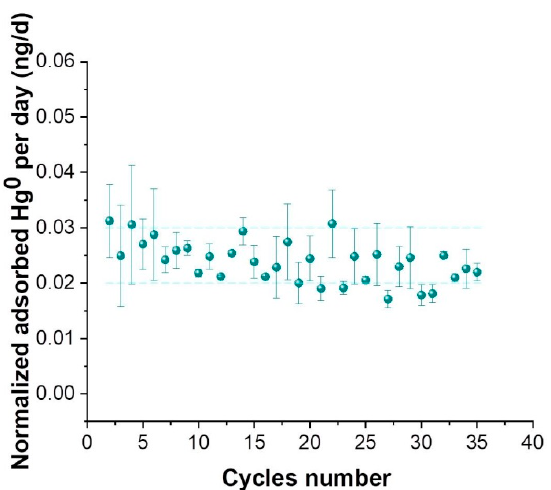
Figure 10. Normalized adsorbed mercury data as function of exposure cycles with an error bar for standard deviation.